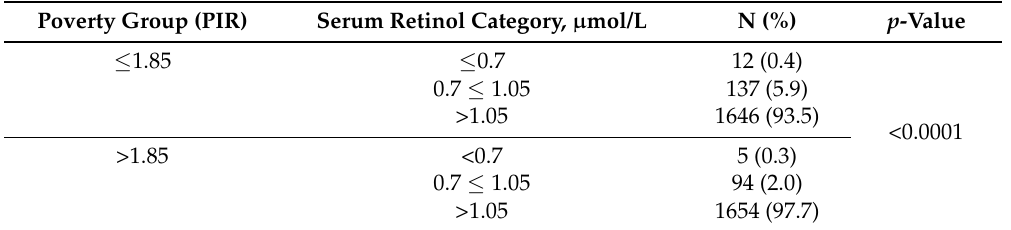
Table 2. Proportion of participants in each vitamin A category, by PIR.